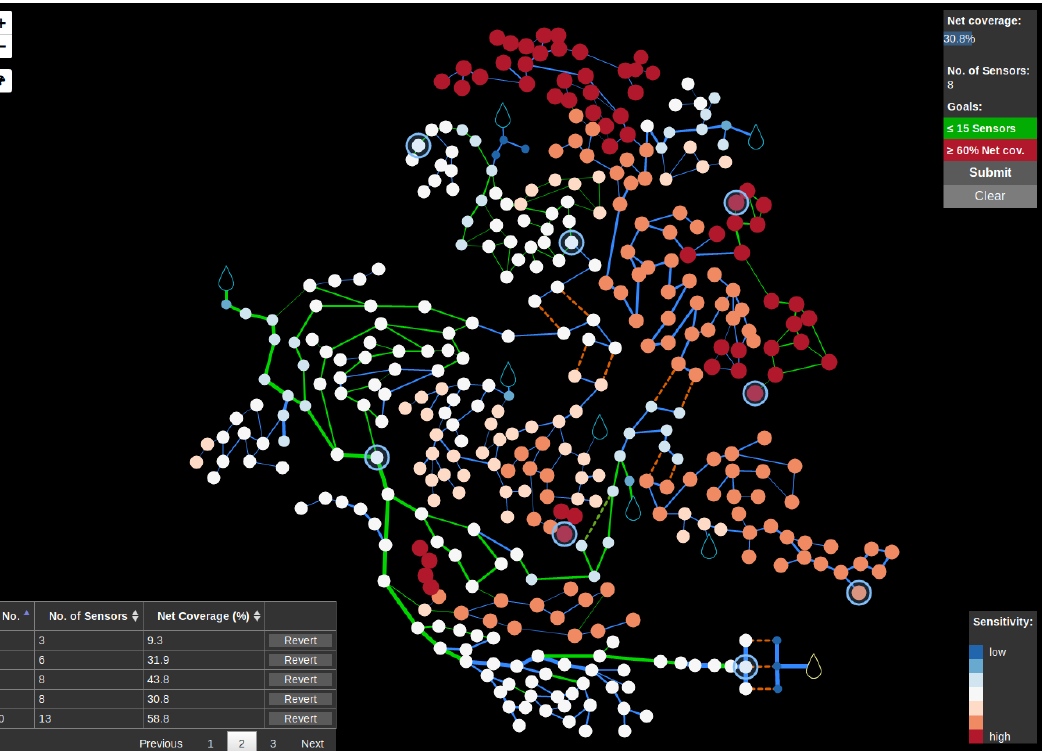
Figure 5. Serious Sensor Placement (SSP) graphical user interface (GUI) showing the C-Town